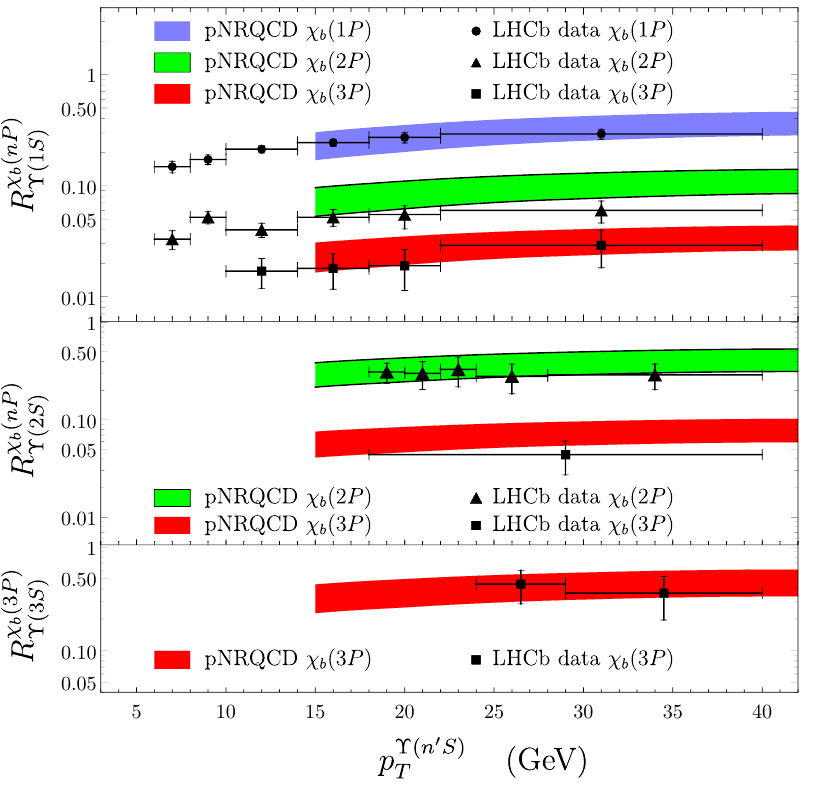
√ s = 7 TeV and in the